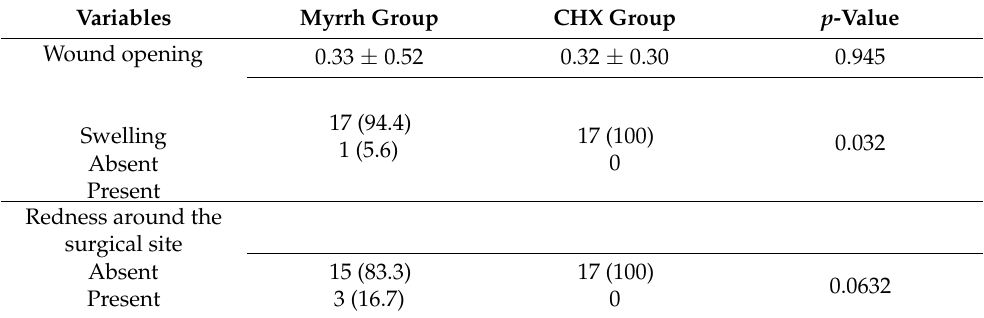
Table 3. Clinical